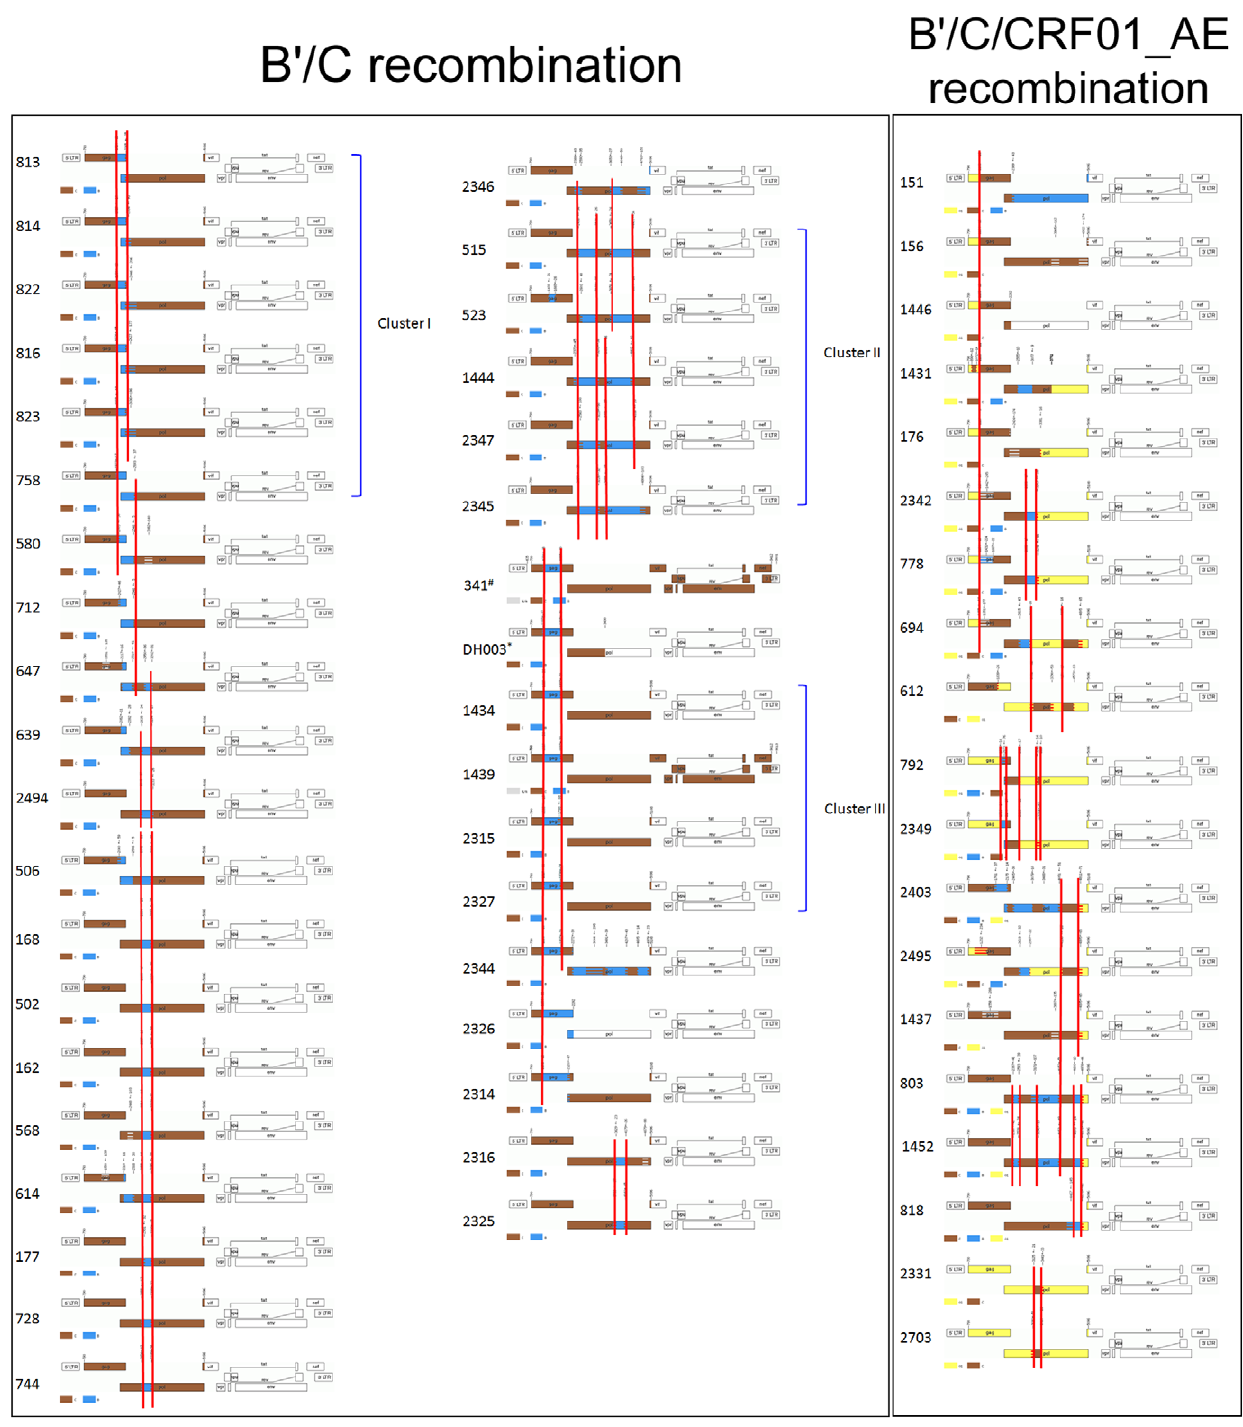
Figure 2. Genome maps of unique recombinant forms harboring same breakpoints. jpHMM-HIV software available at (http://jphmm. gobics.de/) was used to calculate the posterior probabilities of the subtypes at each sequence position and draw the genome map. All genome composed of subtype B 9 and C were put in the left frame while genome containing CRF01_AE segments were put in the right frame. Same breakpoints in different genome schematics were labeled with red line. *DH003 strains was obtained from Yang’s paper [22]. # 341 strain was obtained from HIV Los Alomas database and published in Liu’s paper [26].